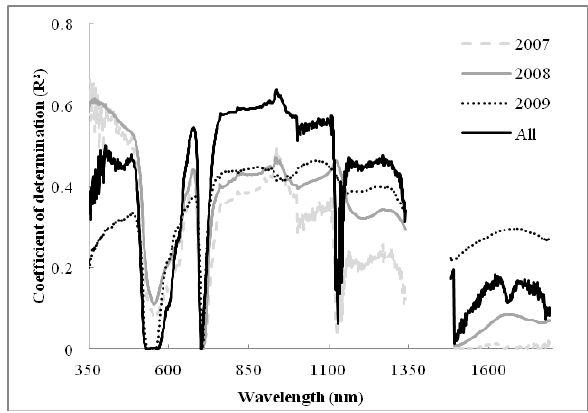
2009 data. For all the following spectral analyses, the three years are considered together.